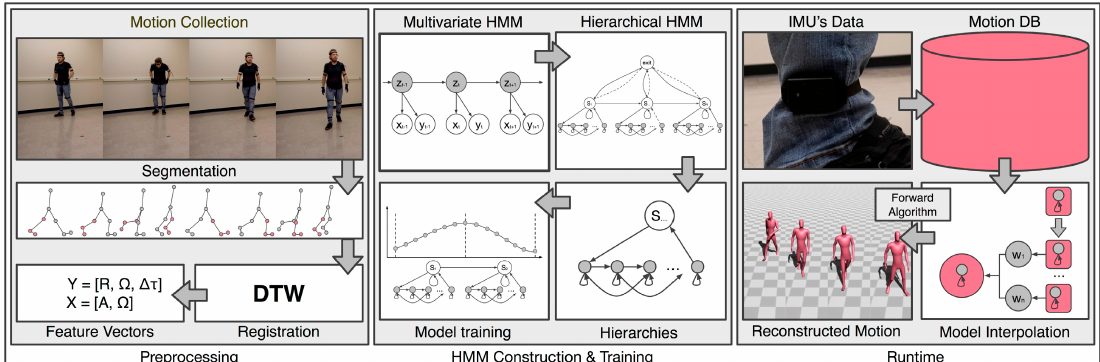
Figure 2. Overview of the